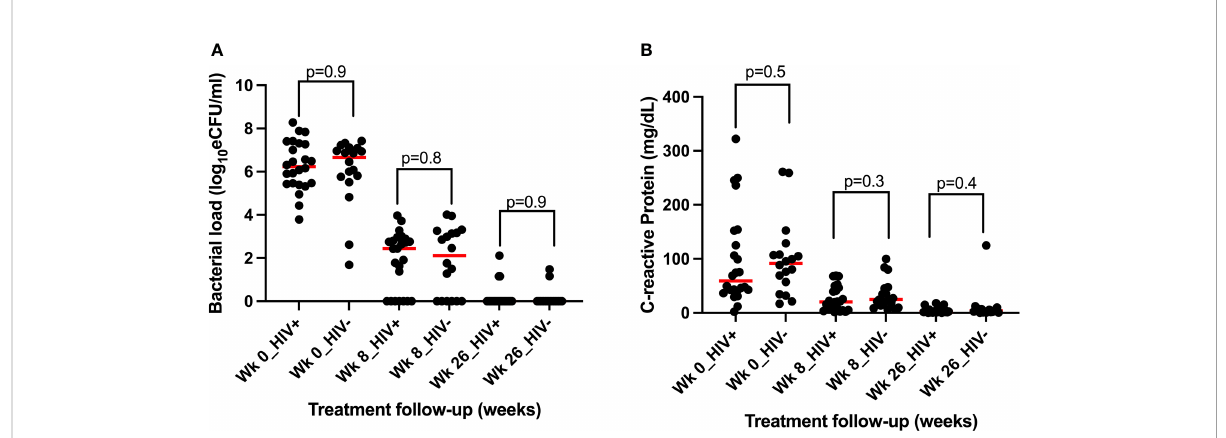
FIGURE 6 Assessment of the impact of HIV status on the resolution of TB bacillary load measured by the TB-MBLA (A) and on the concentration of blood CRP (B) resolution among 43 tuberculosis patients before (week 0) and at weeks 8 and 26 of the treatment